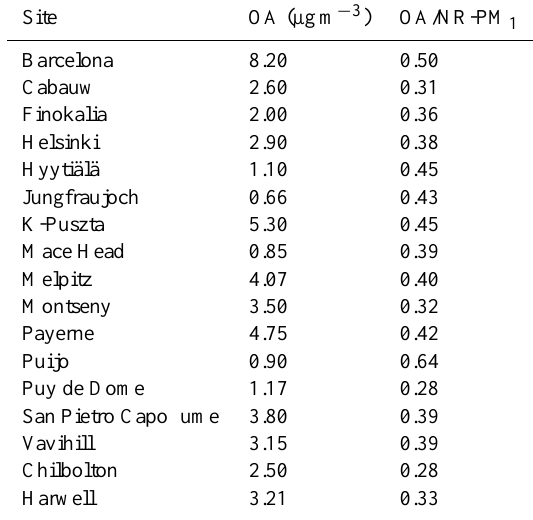
Table 1. Average organic concentrations (OA) and their relative contributions to the NR-PM 1 mass measured by the